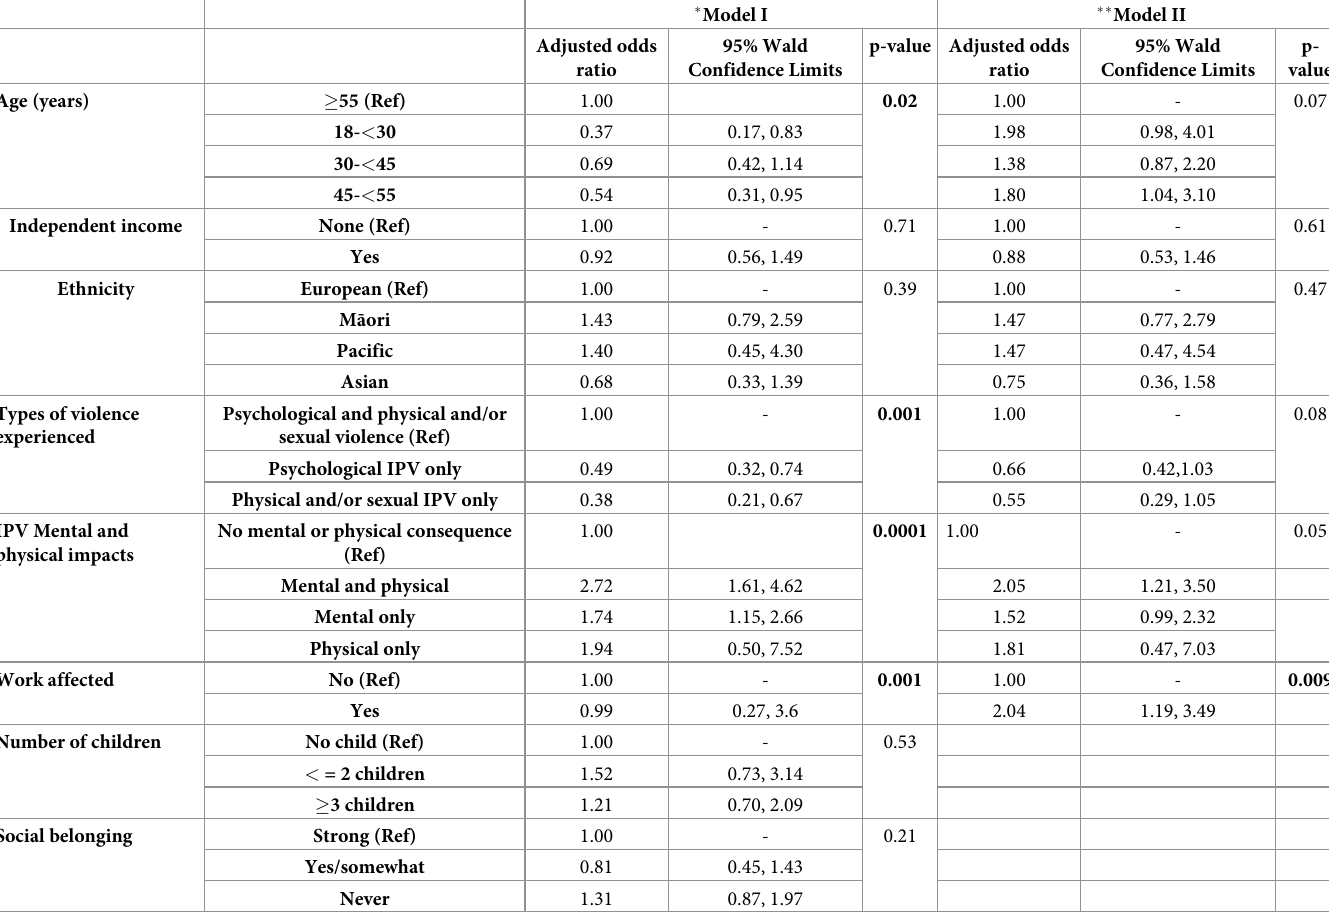
Table 2. Determinants of help-seeking by women who have experienced IPV compared with women who did not seek